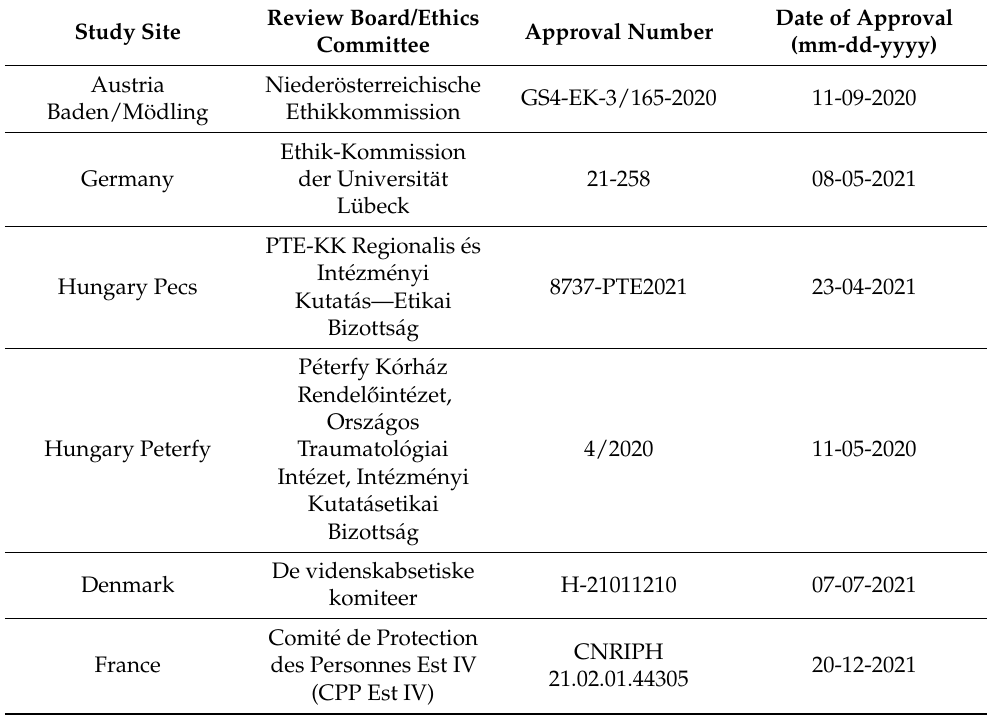
Table A1. List of Institutional Review Boards and Ethics Committees